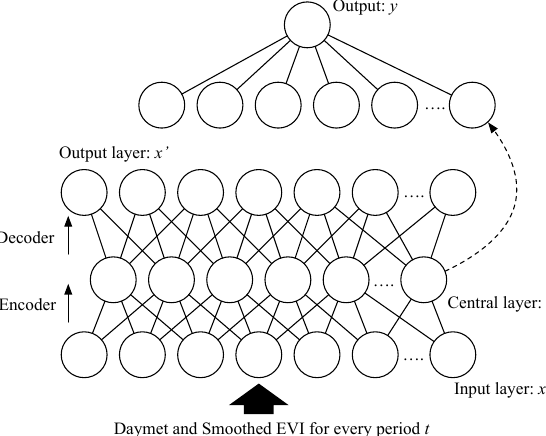
Figure 8: Diagram of the autoencoder used in this study and the rest was used to evaluate the accuracy of the estimation